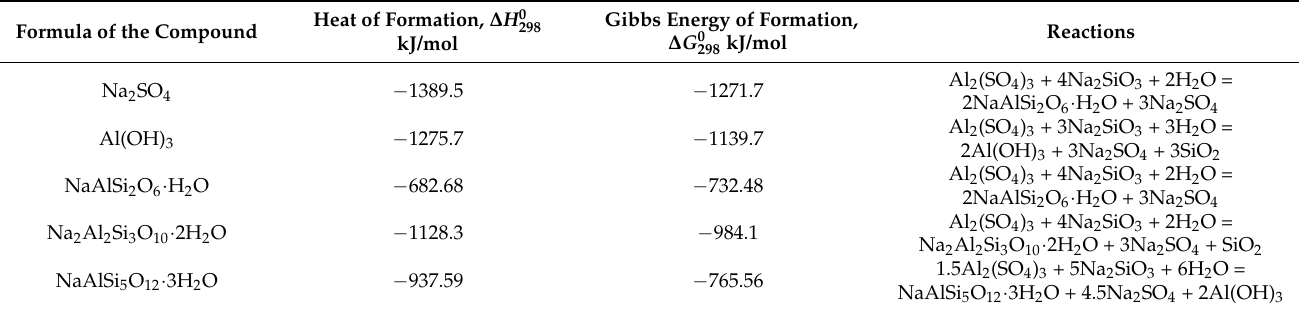
Table 8. Thermodynamic parameters of isobaric–isothermal reactions for the production of synthetic